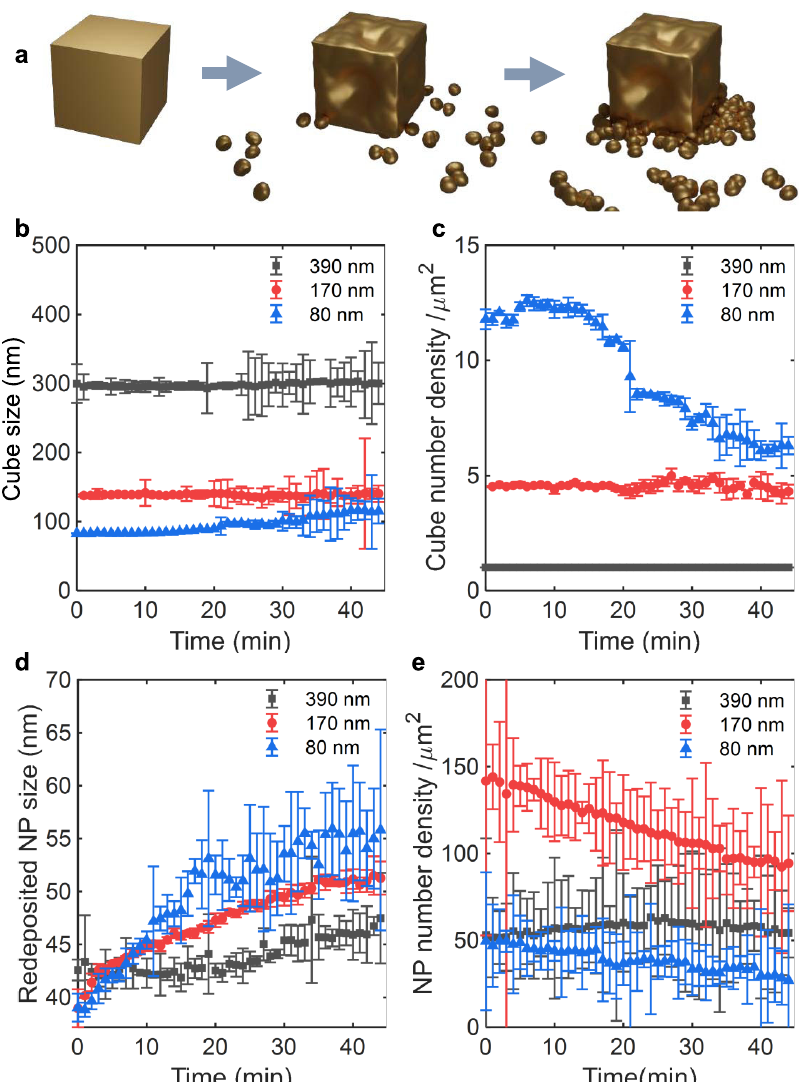
Fig. 4 Catalyst size changes over 45 min from in situ imaging. a Schematics describing the evolution of the cube morphology and the re-deposition of catalyst particles. b The average cube size, c the number density of cubes, and d re-deposited particle size and e the number density of the re-deposited particles extracted from in situ CO 2 RR experiments collected over 45 min. The error bars represent the segmentation error from the automated NP detection processing routine (see “ Methods ” section for